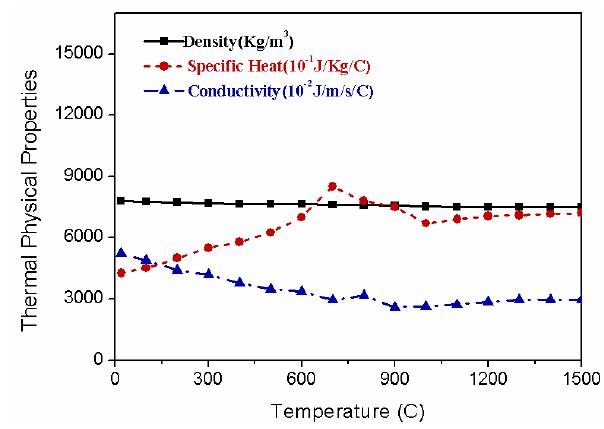
Figure 4. Thermal physical properties of Q235 as a function of temperature.